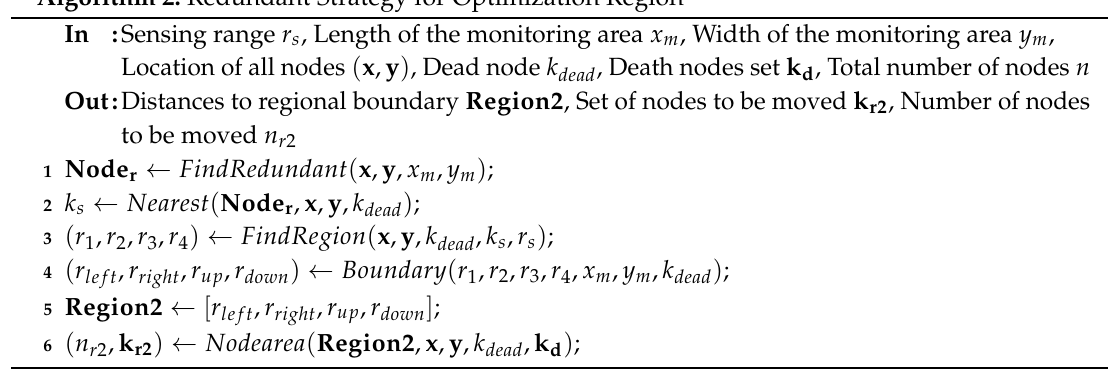
Algorithm 2: Redundant Strategy for Optimization